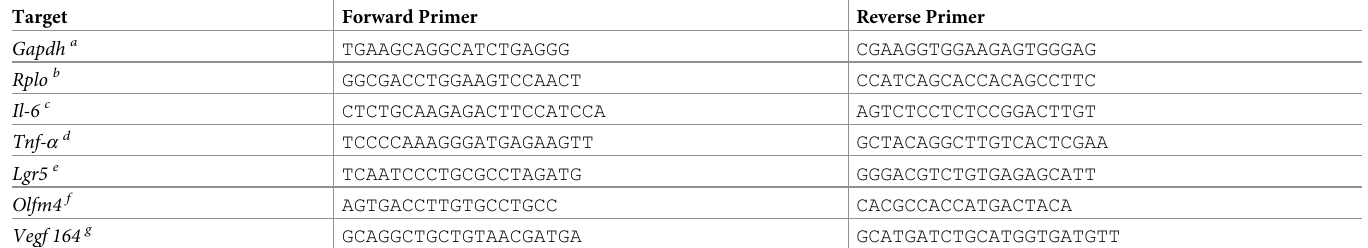
Table 1. Primer sequences used for RT-qPCR